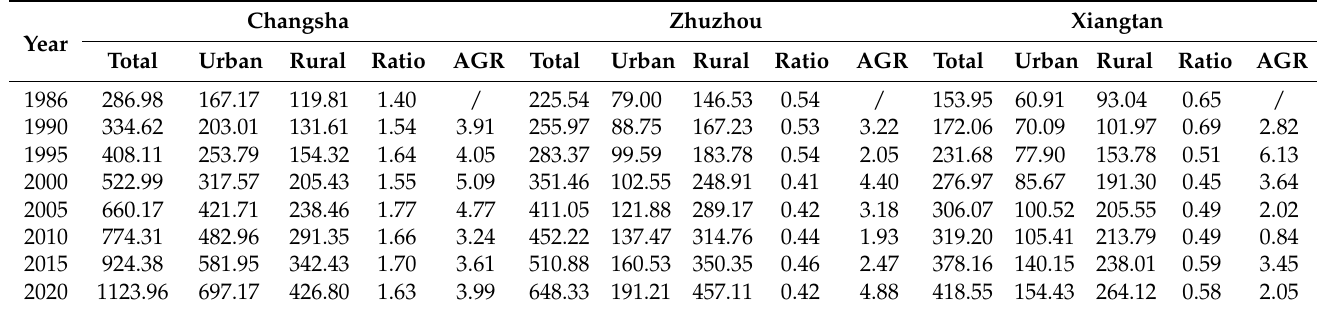
Figure 4. The growth of developed land in the CZT urban megaregion from 1986 to 2020: ( a ) the spatial patterns of the newly developed land, ( b ) the area and the differences in developed land between urban and rural areas, and ( c ) the annual growth rate of developed land. Table 1. Urban and rural differences in developed land changes from 1986 to